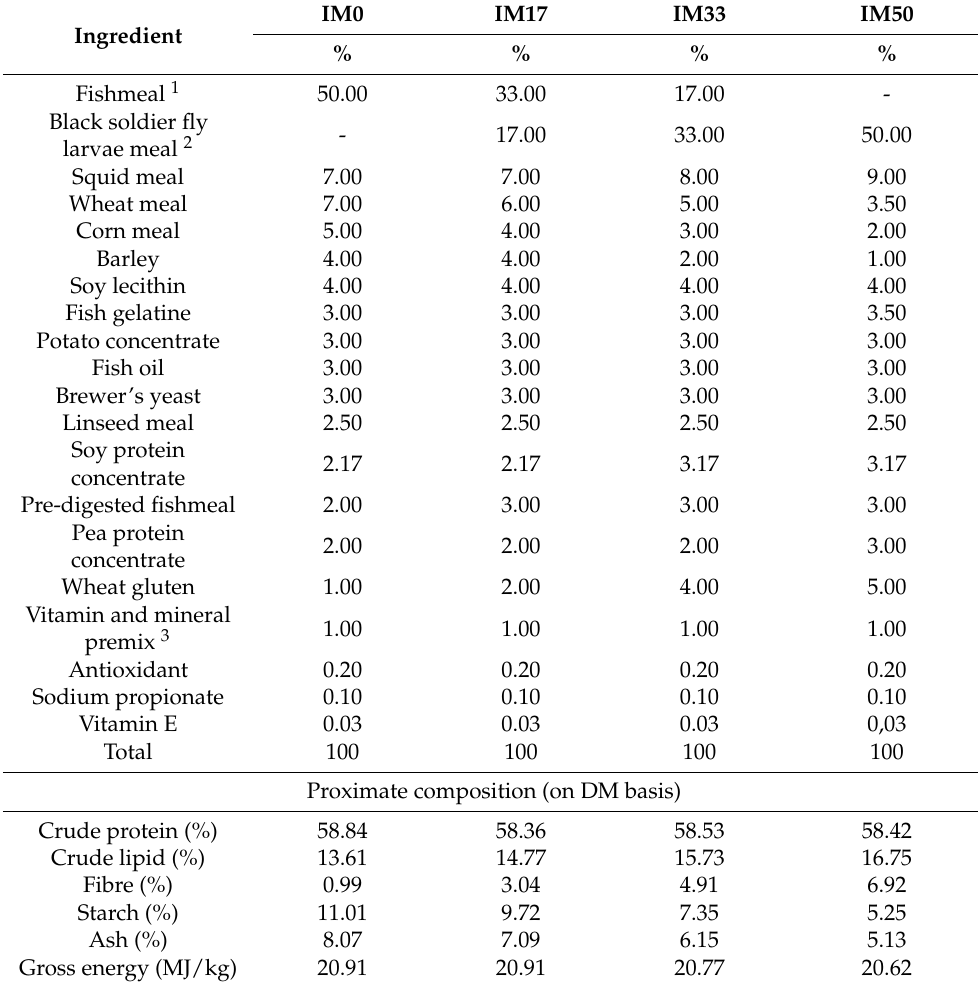
Table 1. Ingredients and proximate composition of the experimental